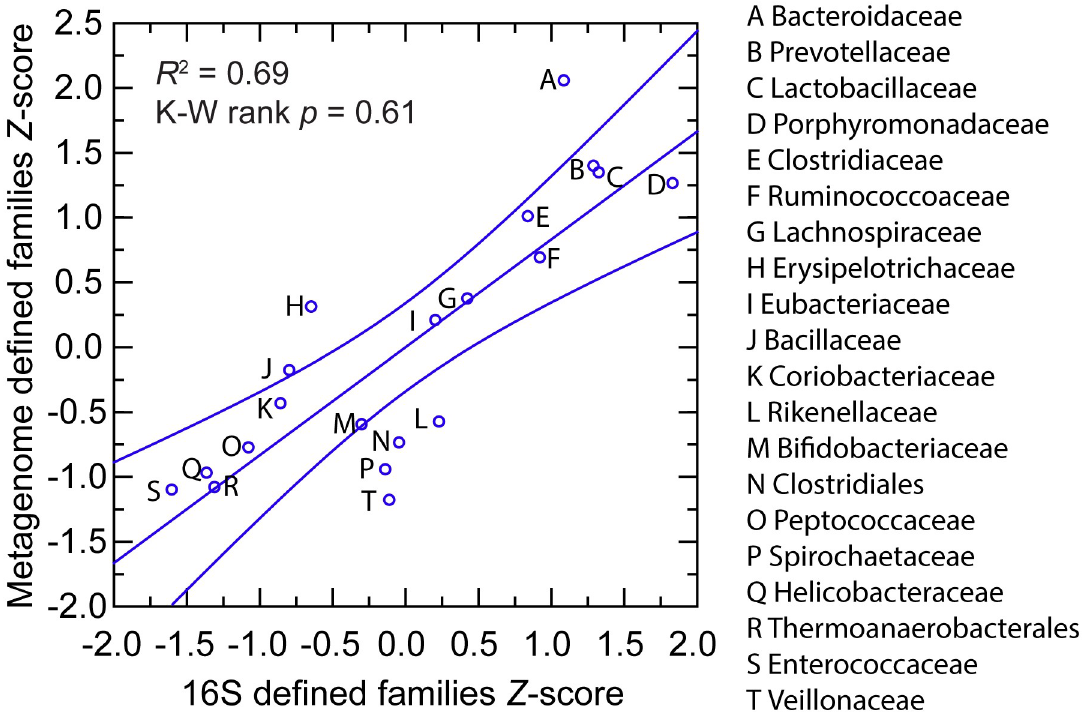
Fig 1. Scatter plot of relative abundances of commonly occurring bacterial families or orders in fecal metagenomes of Peromyscus leucopus LL stock by 16S ribosomal RNA gene criterion ( x -axis) and by genome-wide metagenome criterion ( y -axis). The values of the two methods were normalized by Z -score. The different taxa are indicated in the graph by capital letters, which are defined in the box to the right. The linear regression curve and its 95% confidence interval is shown. The coefficient of determination ( R 2 ) value and the Kruskal-Wallis (K-W) test by ranks p value are given.